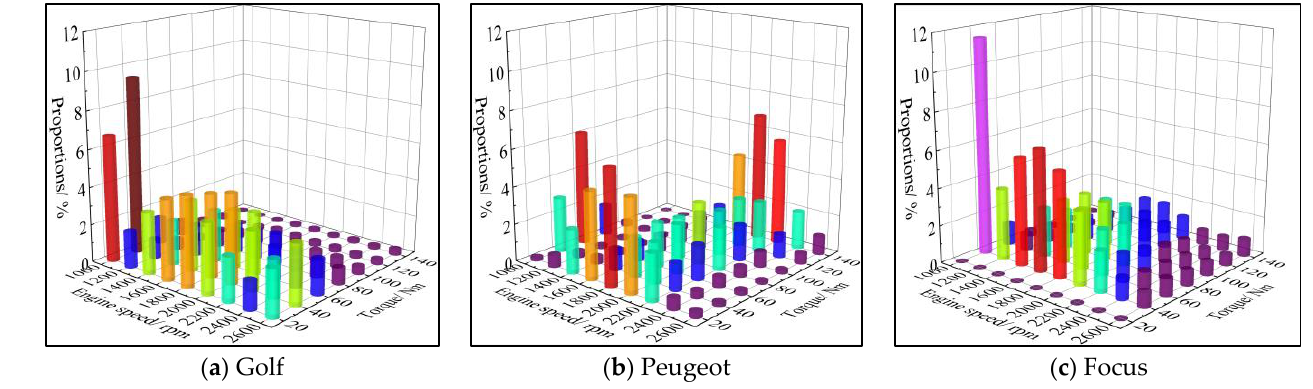
Figure 3. Operation distribution vs. engine speed and torque.